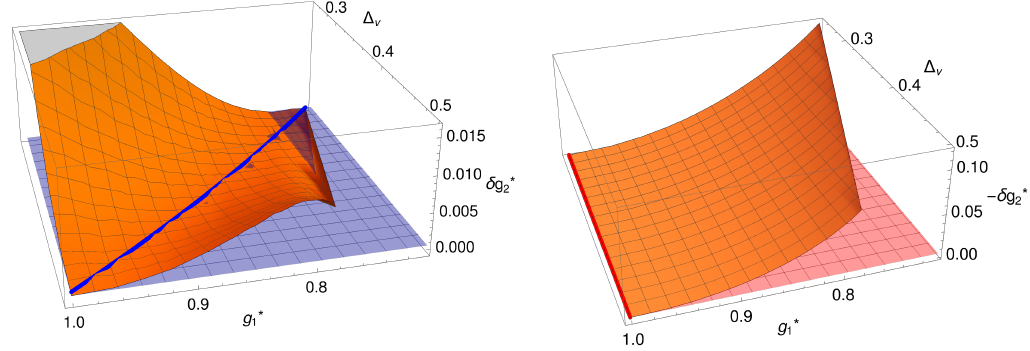
as a function 2 = 1 , ∆ v = 1 = 0 , and thick colored lines i